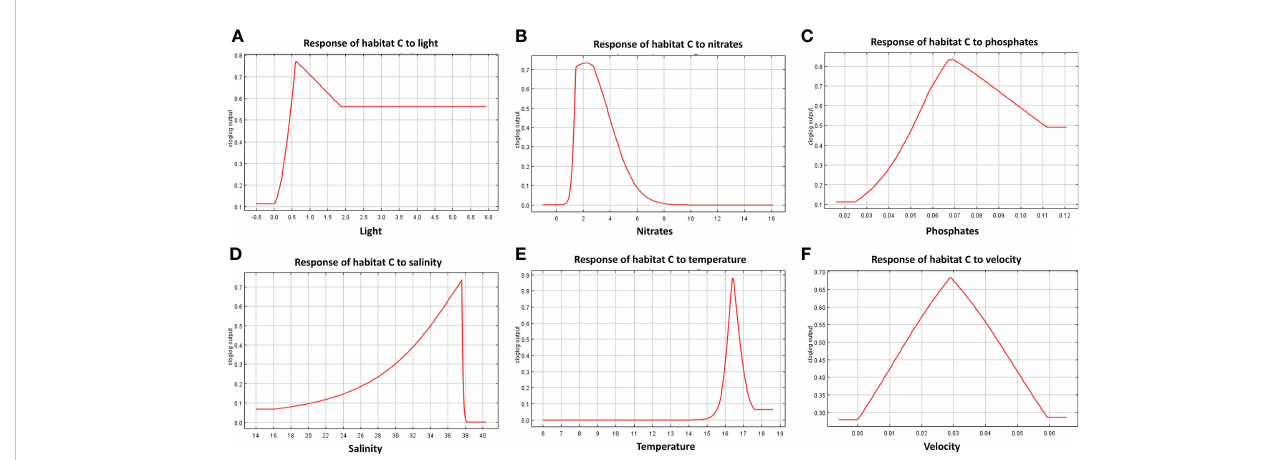
FIGURE 9 Response curves derived from MaxEnt reporting the relationship of predicted suitability of habitat C to environmental variables, with y-axis indicating the probability values and x-axis the concentration/intensity of the variables: (A) relationship between habitat C and light; (B) relationship between habitat C and nitrate concentration; (C) relationship between habitat C and phosphate; (D) relationship between habitat C and salinity; (E) relationship between habitat C and temperature; (F) relationship between habitat C and current velocity.